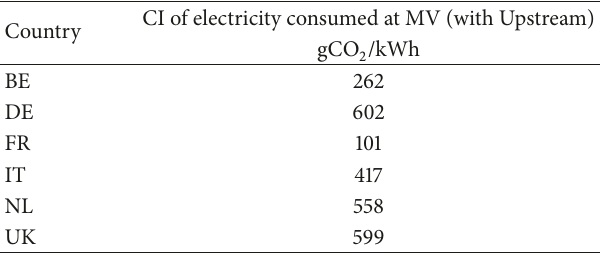
Table 4: Carbon intensity of medium-voltage electricity [19].